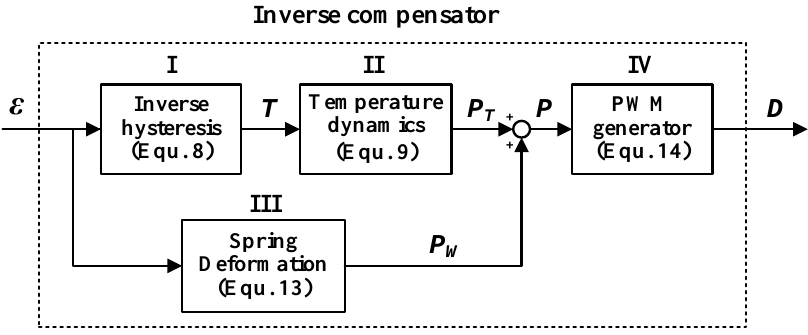
Figure 11. Schematic block diagram of the feed-forward inverse compensator for SMA length control.